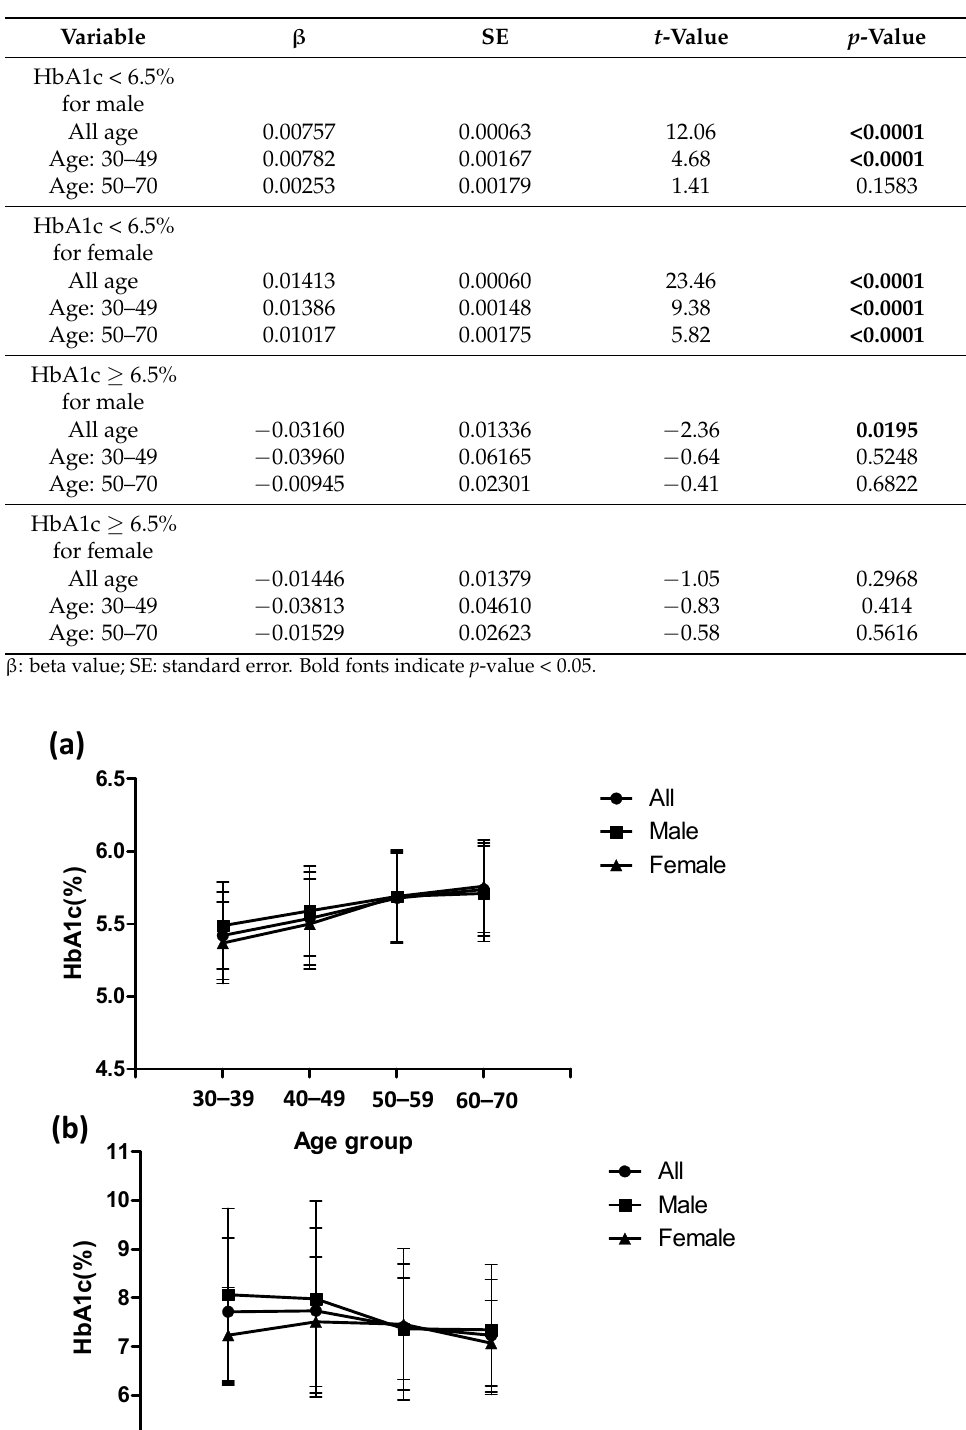
Table 5. Single linear regression between HbA1c levels and age.